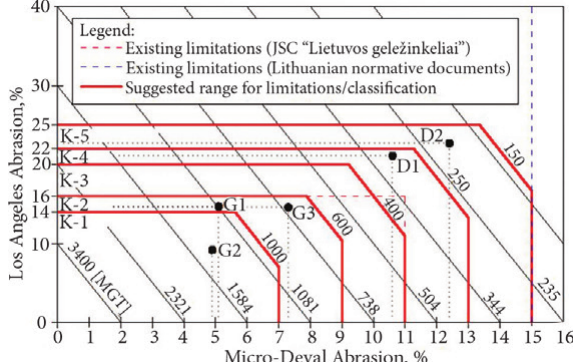
Fig. 6. Classification of Micro-Deval Abrasion and Los Angeles Abrasion indicators as sleepers are made of wood